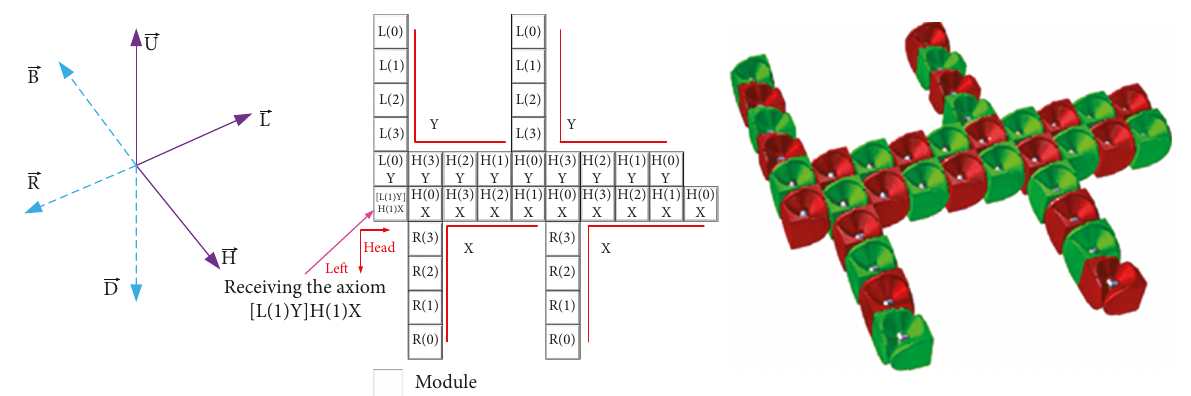
Figure 5: The self-similar character of lattice con fi guration by the L-system in